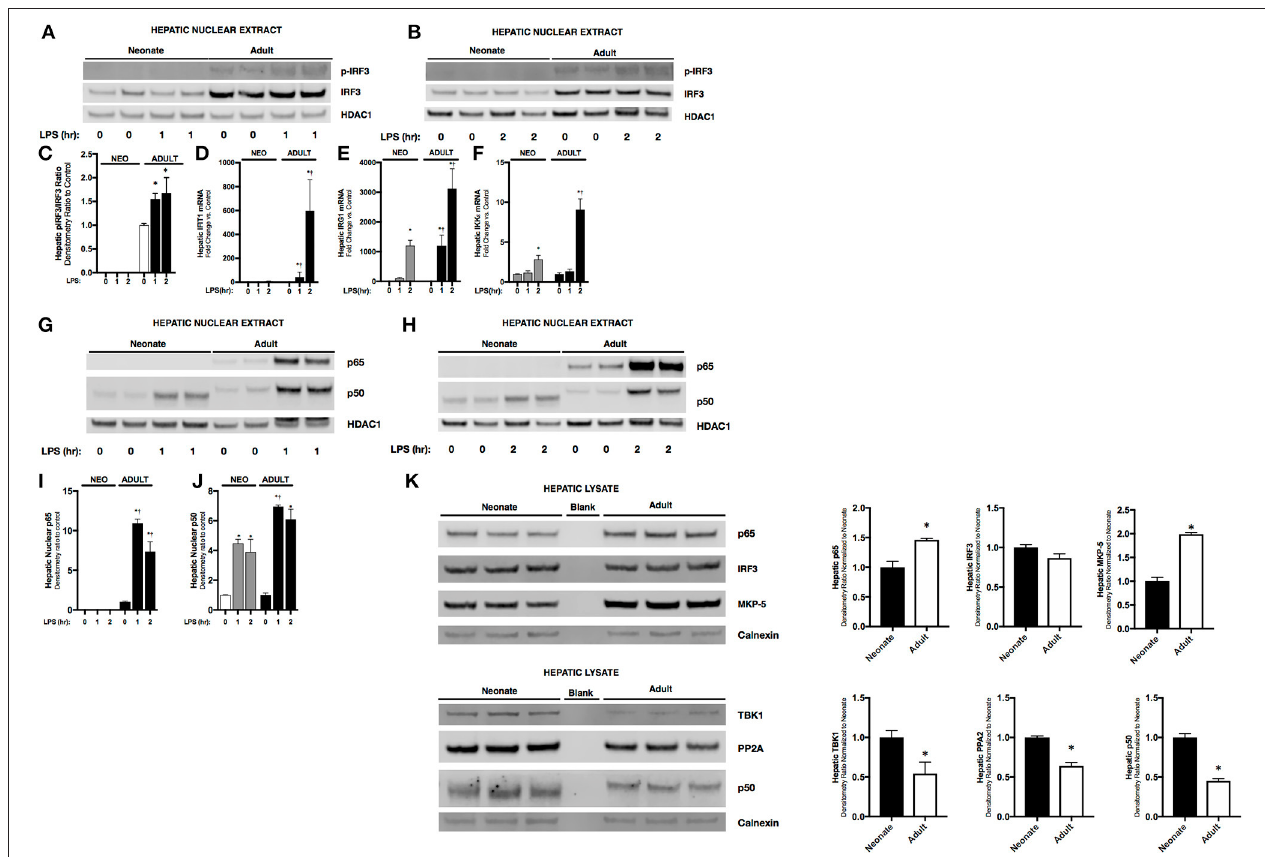
FIGURE 2 | Neonates demonstrate attenuated LPS-induced hepatic IRF3 and p50/NF κ B activation. (A,B) Representative Western Blot showing neonatal and adult hepatic nuclear extracts following 1h (A) or 2h (B) of LPS exposure (5 mg/kg) for phosphorylated and total IRF3 with HDAC1 shown as loading control. (C) Densitometry ratio to control of adult hepatic pIRF3. * p < 0.05 vs. control . Values shown as means ± SEM; n = 3/timepoint (D–F) Fold-increase in gene expression in neonatal and adult hepatic IFIT1, IRG1, and IKK ε following LPS exposure (0–2h, 5 mg/kg) * p < 0.05 vs. control; † p < 0.05 vs. LPS-exposed neonate. Values shown as means ± SEM; n = 3–6/timepoint. (G, H) Representative Western Blots showing neonatal and adult hepatic nuclear extract following 1h (G) or 2h (H) LPS exposure (5 mg/kg) for NF κ B subunits p65 and p50 with HDAC1 shown as loading control. (I,J) Densitometry ratio to control of p65 or p50 in neonatal and